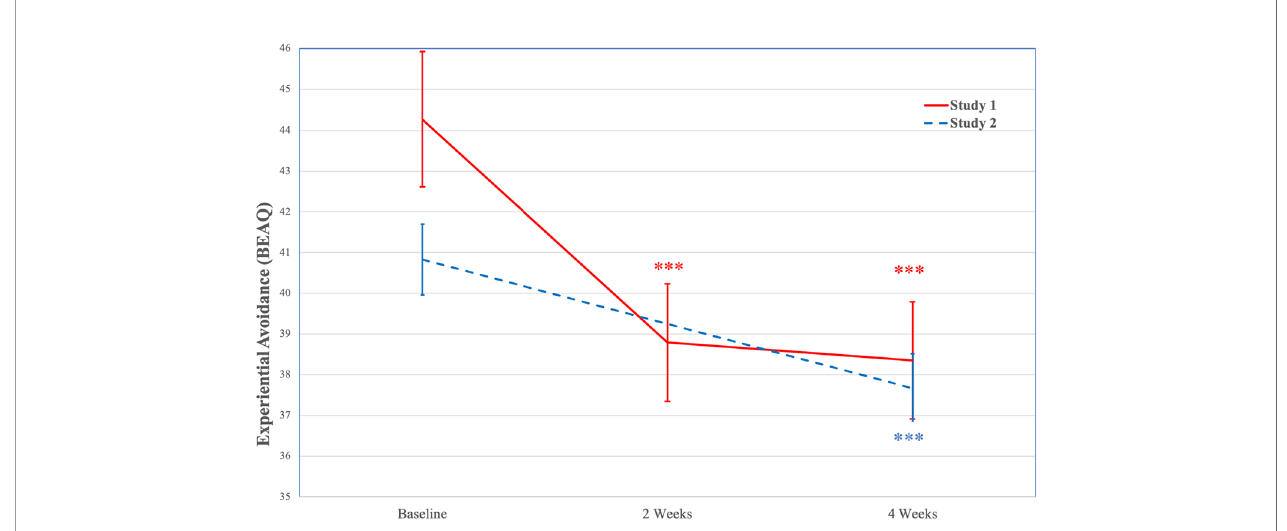
FIGURE 1 | Decreases in Experiential Avoidance (BEAQ) Over Time (Study 1 and Study 2). Note. Study 1 N =104; Study 2 N =254; BEAQ is only assessed at baseline and 4-weeks in Study 2; *** p < .001. BEAQ, Brief Experiential Avoidance